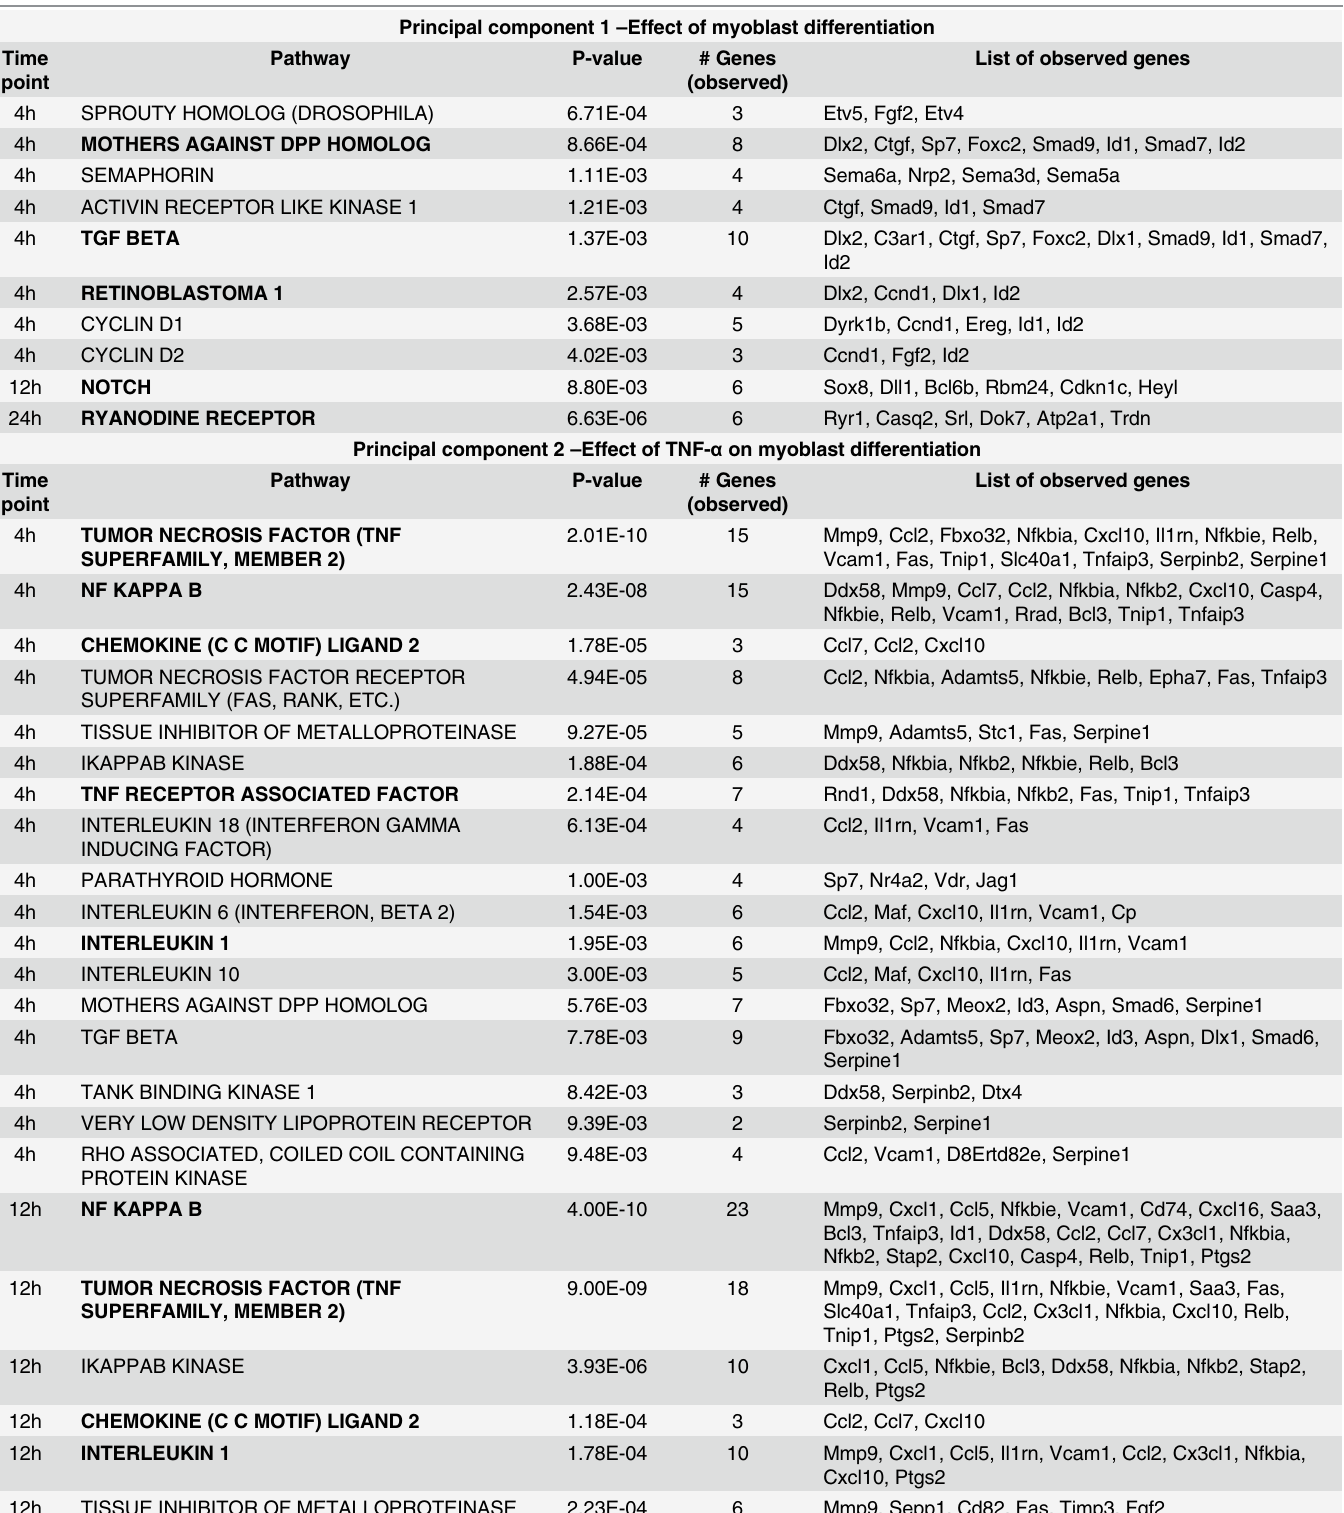
Table 1. Pathway enrichment analysis of genes separated by principal